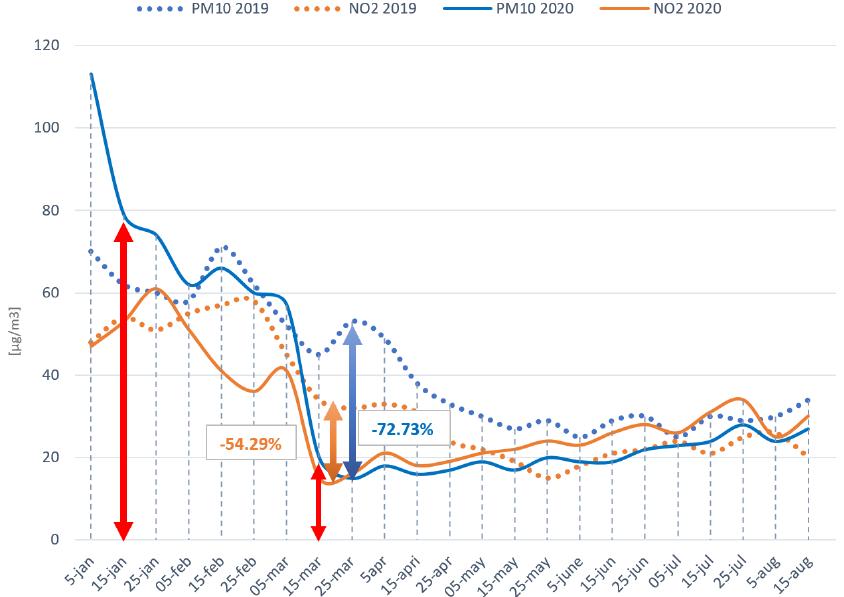
Figure 4. Chart of air pollutants in Milan (measuring station of Saronno Santuario) from January to August of 2019 and 2020. Source: Own elaboration by data collected from AQICN [18].